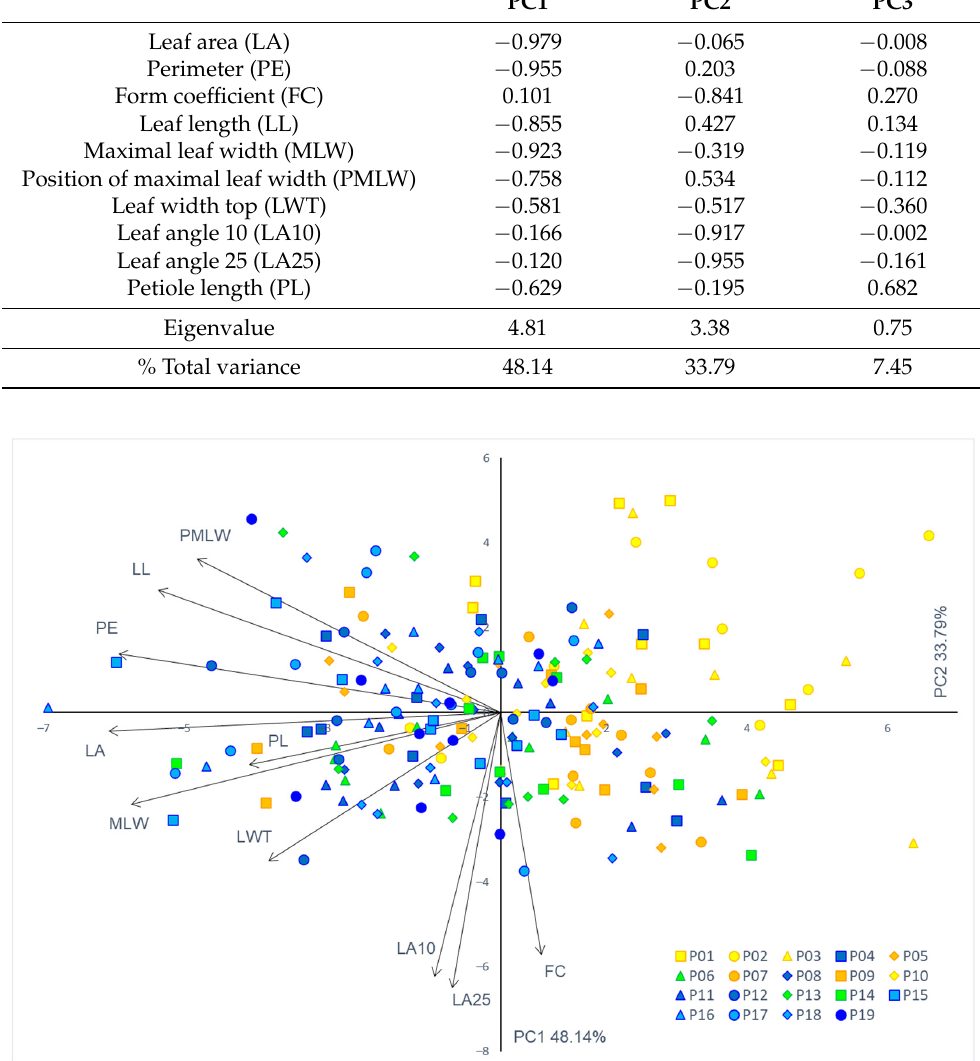
Figure 3. Biplot of the principal component (PC) analysis based on 10 leaf phenotypic traits in the studied Pyrus pyraster populations. Leaf phenotypic traits: LA—leaf area; PE—perimeter; LL—leaf length; MLW—maximum leaf width; PMLW—leaf length, measured from the leaf base to the point of maximum leaf width; LWT—leaf width top; PL—petiole length; FC—form coefficient; LA10—angle closed by the main leaf vein (the center of the leaf blade) and the line connecting the leaf blade base to a set point on the leaf margin at 10% of total leaf blade length; and LA25—angle closed by the main leaf vein (the center of the leaf blade) and the line connecting the leaf blade base to a set point on the leaf margin at 25% of total leaf blade length. Populations: P01—Kuberton;